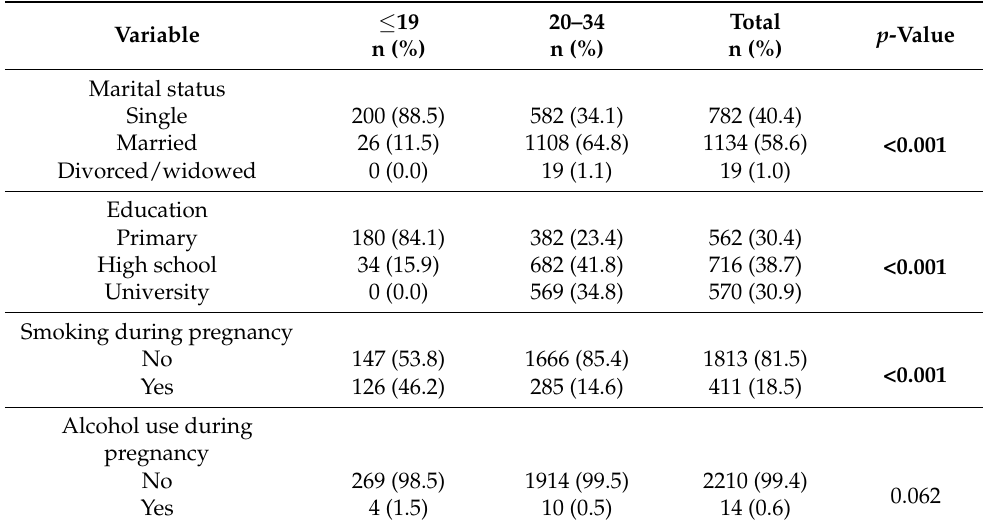
Table 1. Characteristics of the sample by maternal age.